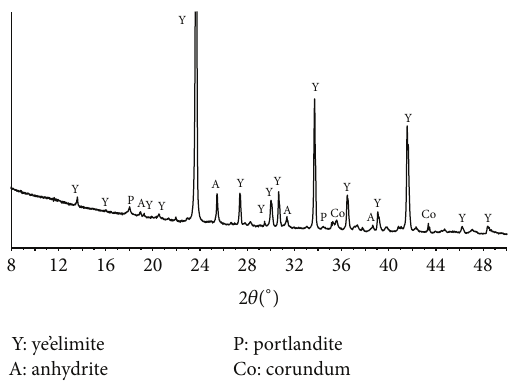
Figure 1: XRD pattern of ye’elimite clinker.